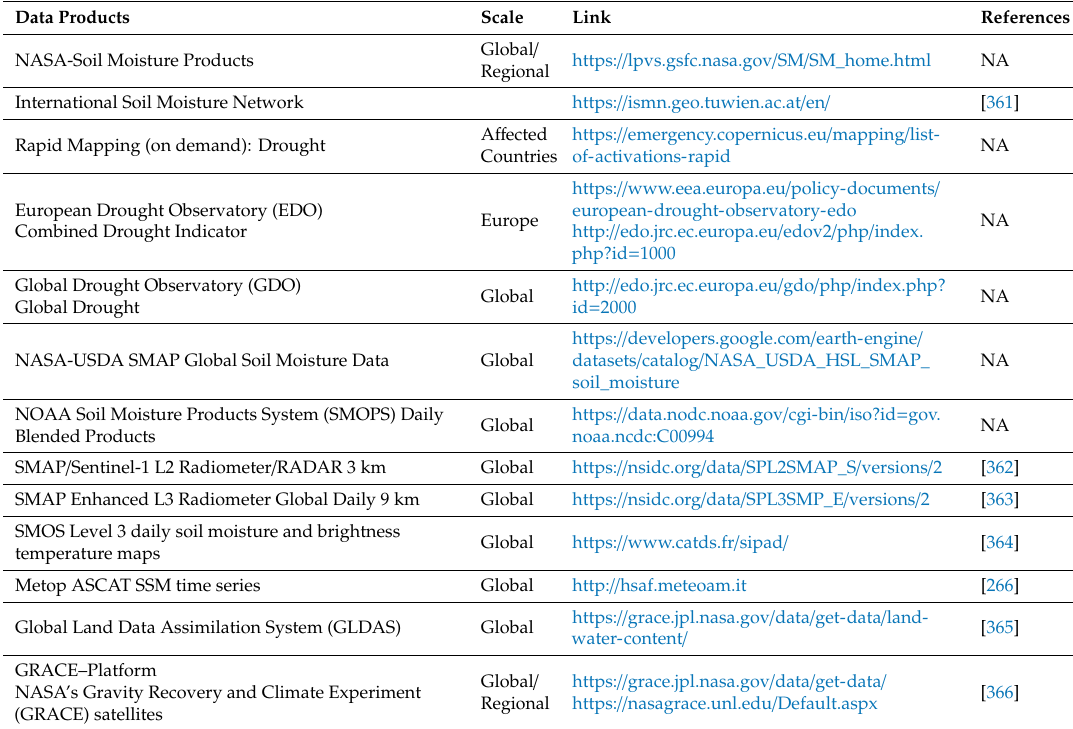
Table 6. Selection of RS-aided data products of soil moisture estimation with